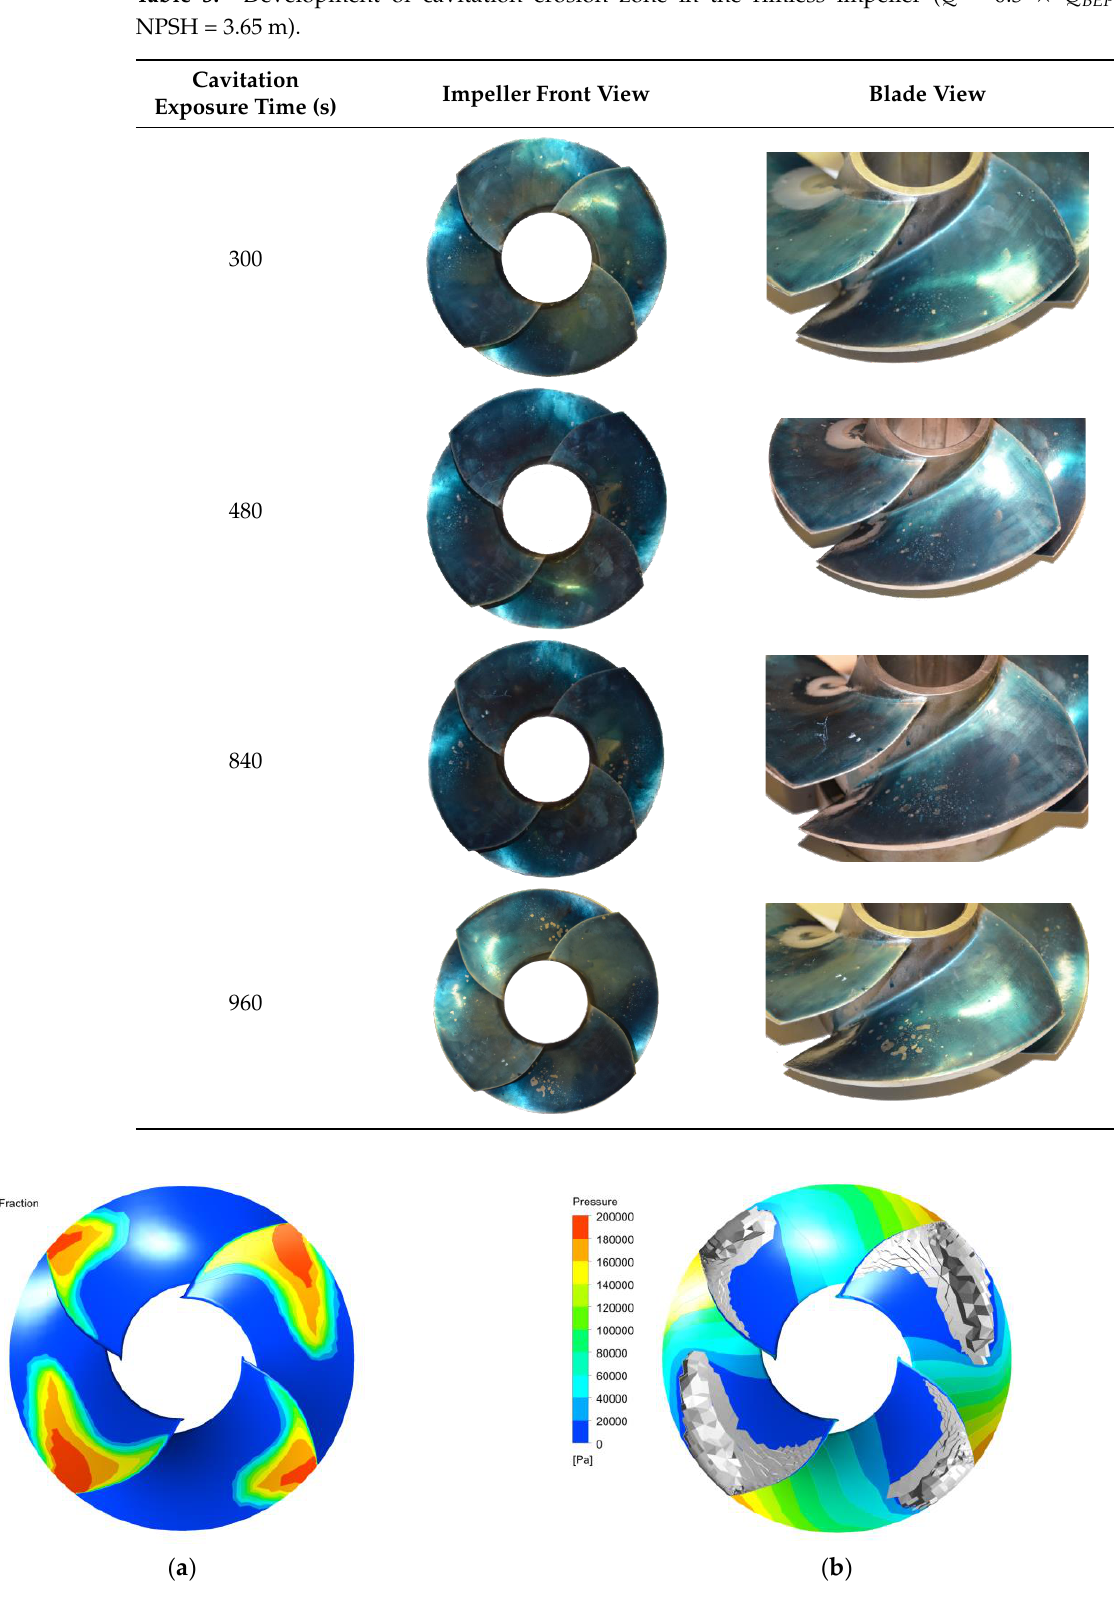
Figure 8. Cavitation erosion zones on the suction surface of rimless impeller № 2 ( Q = 0.3 × Q BEP , NPSH = 3.65 m). The analysis of Figures 7 and 8 shows that cavitation destructions of the easily break- able paint coating appear behind the vapor region in the area, where the static pressure exceeds the atmospheric pressure and the bubbles collapse. Cavitation erosion at non- optimal flow Q = 0.3 × Q BEP is accompanied by a calculated vapor zone occupying about 20% of the blade area. At the same flow rate Q = 0.3 × Q BEP , but with NPSH = NPSH3 = 2 m, cavitation failure of pump parameters occurs. This failure corresponds to a vapor area occupying almost the whole surface of the blade (Figure 9).